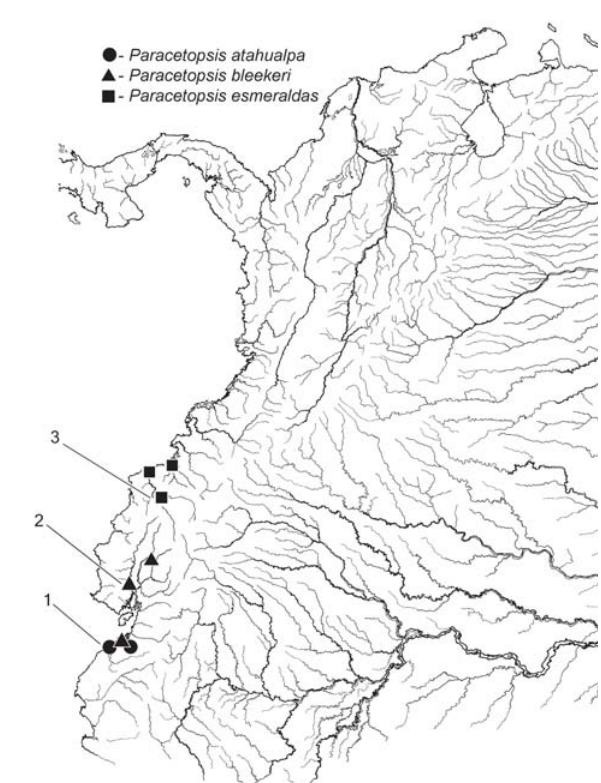
Fig. 55. Map of northwestern South America showing geo- graphic distribution of Paracetopsis atahualpa (1 = holo- type locality), Paracetopsis bleekeri (2 = neotype locality; also holotype locality for Cetopsis occidentalis ), and Paracetopsis esmeraldas (3 = holotype locality) (some sym- bols represent more that one locality and/or lot of